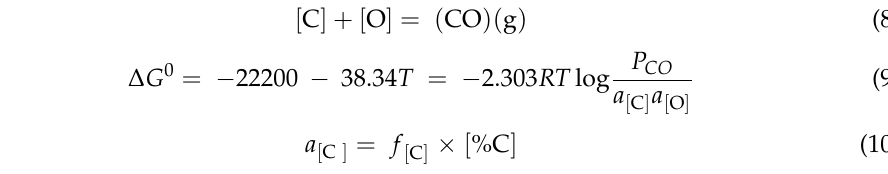
Figure 11. Changes in the P O of dephosphorization.